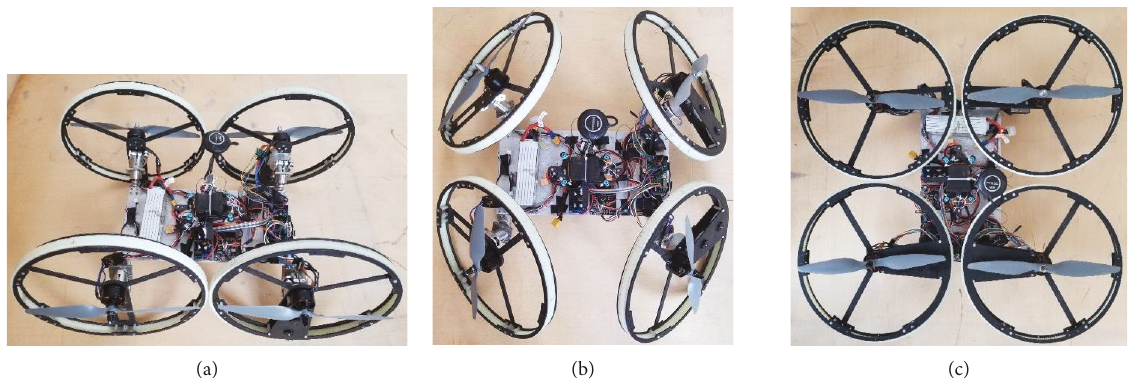
Figure 11: Representations of the physical prototype state: (a) the terrestrial locomotion mode, (b) the state of mode transformation, and (c) the aerial locomotion